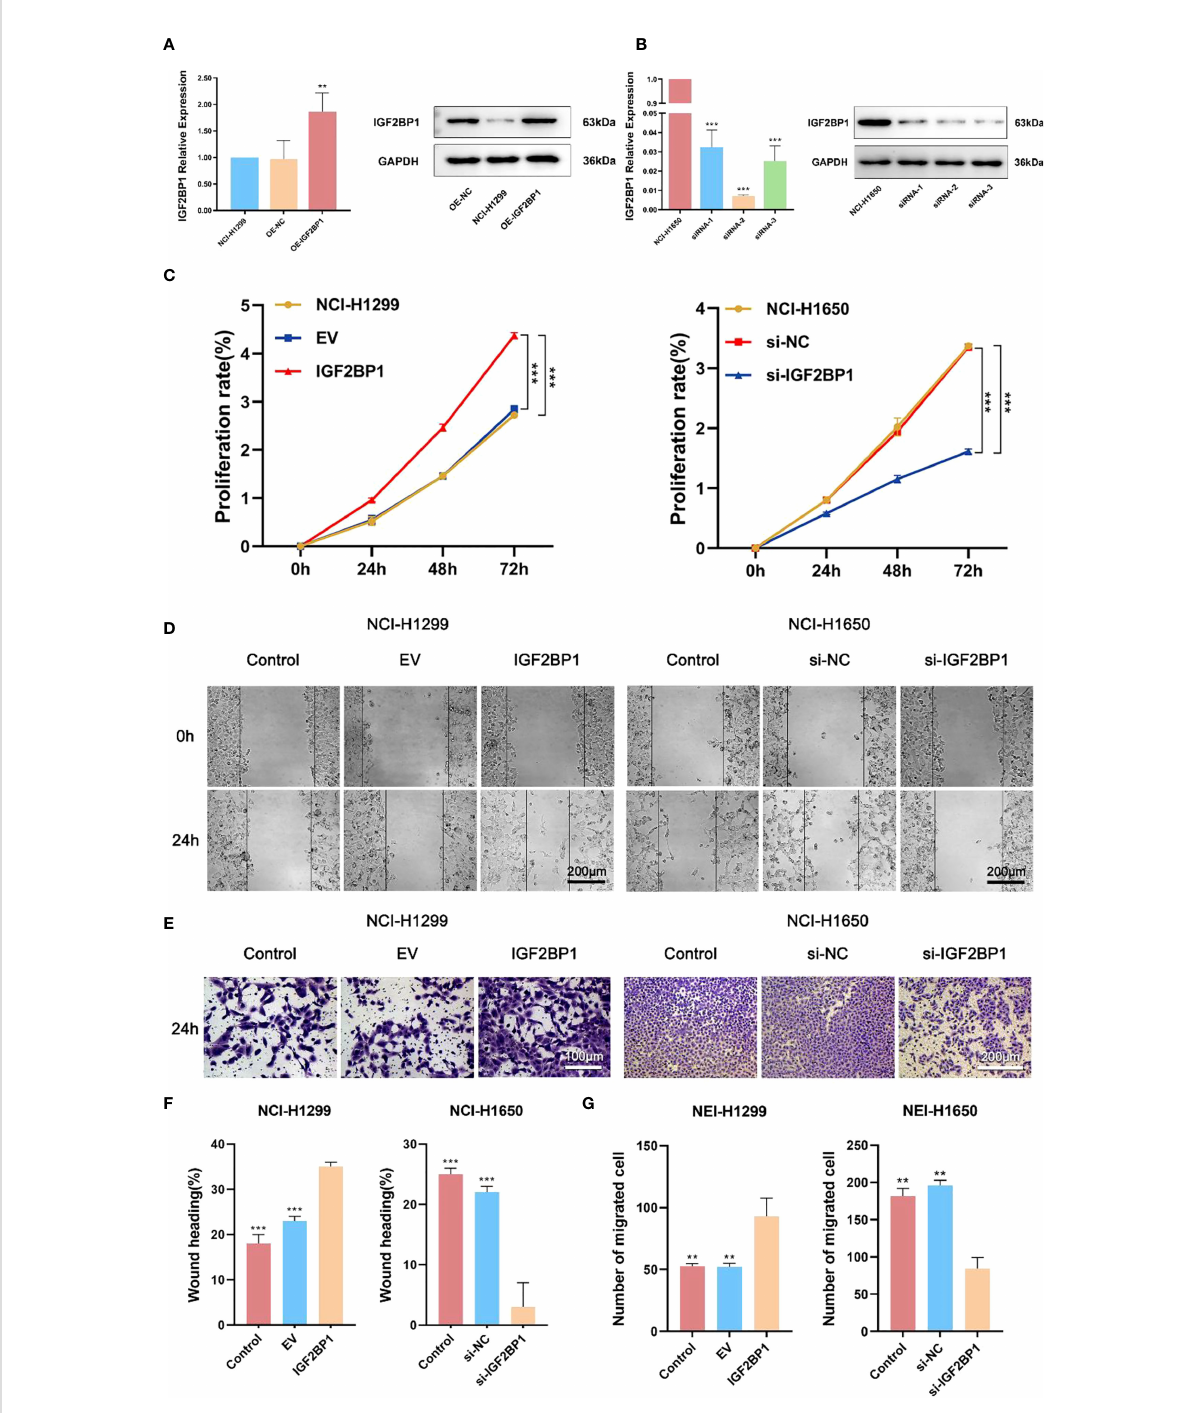
FIGURE 6 IGF2BP1 promoted proliferation and invasion of LUAD cell lines. (A) Empty or IGF2BP1 expressing plasmids were transfected into NCI-H1299 cells. (B) IGF2BP1 siRNA were transfected into NCI-H1650 cells. (C) CCK-8 assay was used for accessing the proliferation of each treatment group of NCI-H1299 cells and NCI-H1650 cells. (D, F) Scratch assay was used for accessing the migration of each treatment group of NCI-H1299 cells and NCI-H1650 cells. (E, G) Transwell assay was used for accessing the invasion of each treatment group of NCI-H1299 cells and NCI-H1650 cells. EV: empty vector group. IGF2BP1: IGF2BP1-overexpressed group. si-NC: negative control siRNA group. si-IGF2BP1: IGF2BP1 knocked-down group. Data are presented as mean ± S.D. P -value was calculated by a two-sided unpaired Student ’ s t-test. **P < 0.01; ***P <